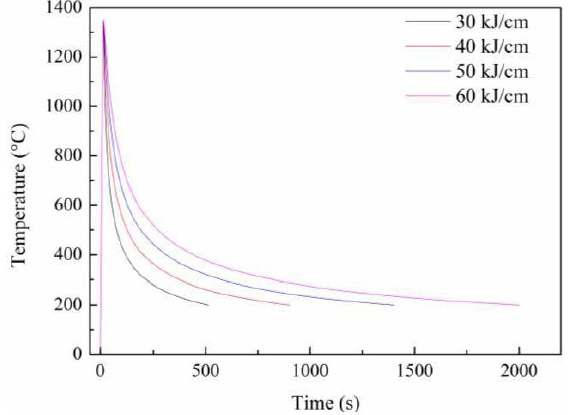
Figure 2. Graph of the simulated thermal cycle on the Gleeble for the steel with different heat inputs. After the simulated thermal cycle, specimens for metallographic observation were cut on the plane perpendicular to the axis of the simulated specimens and near the monitoring thermocouple.